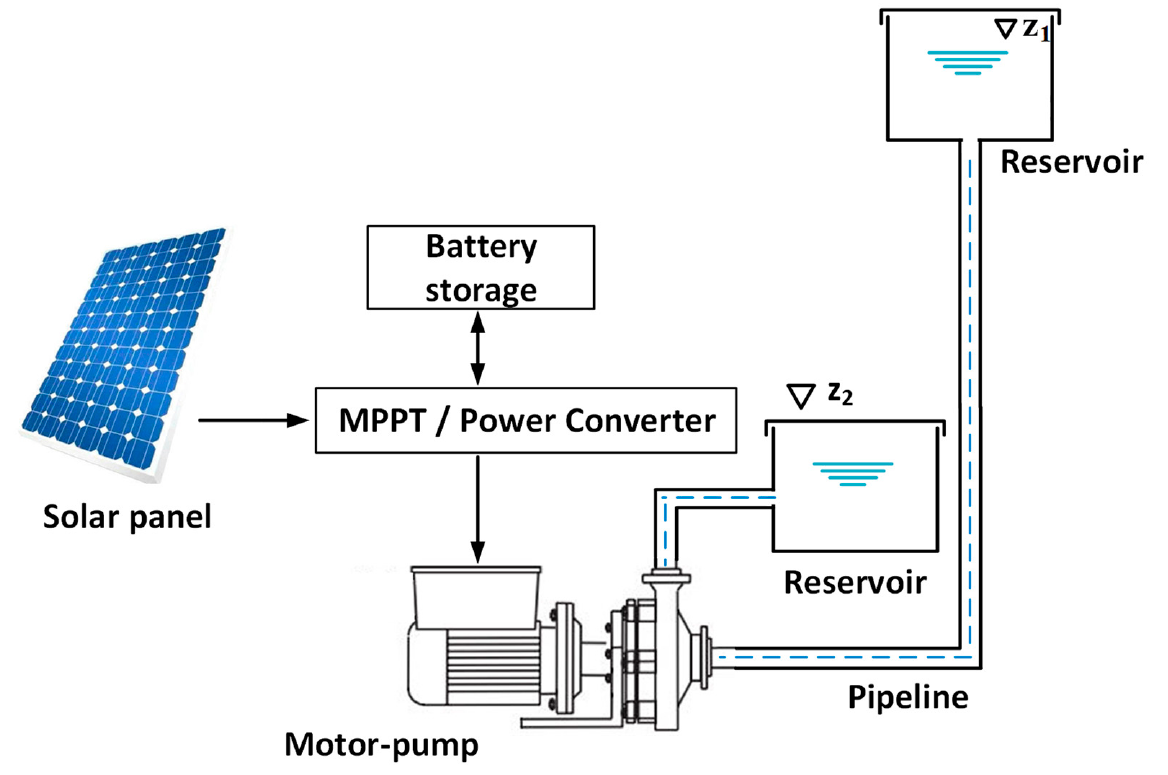
Figure 1. The general structure of the pumping system.